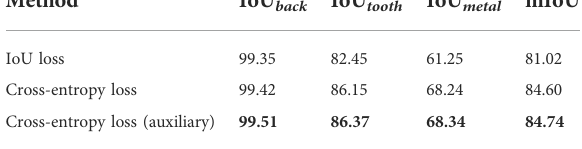
Bold values indicates the best performing parameter.